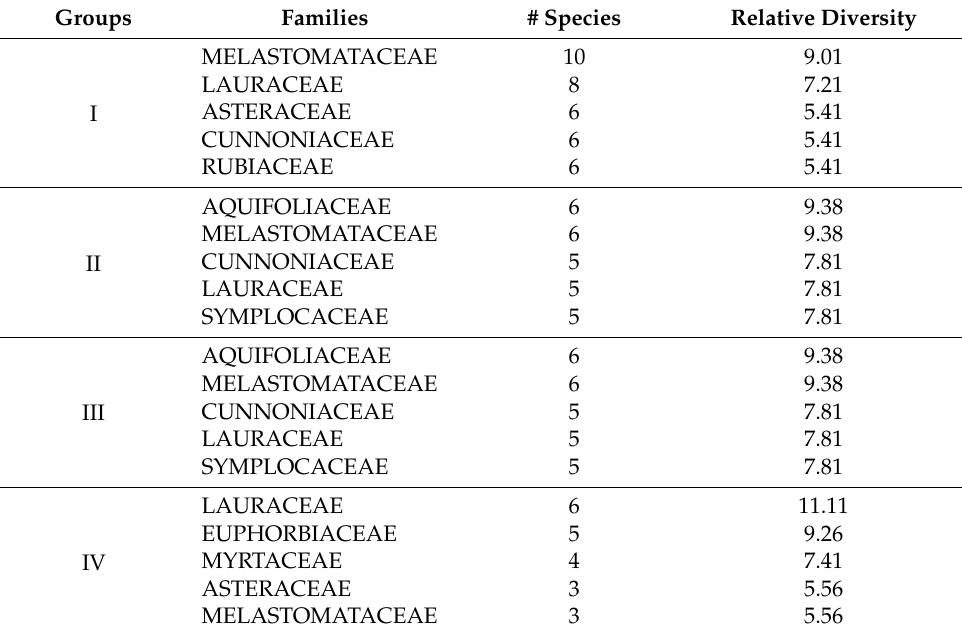
Table 1. Families with more species of the total determined (relative diversity) in the four determined floristic groups (NMDS) of the montane forest in our